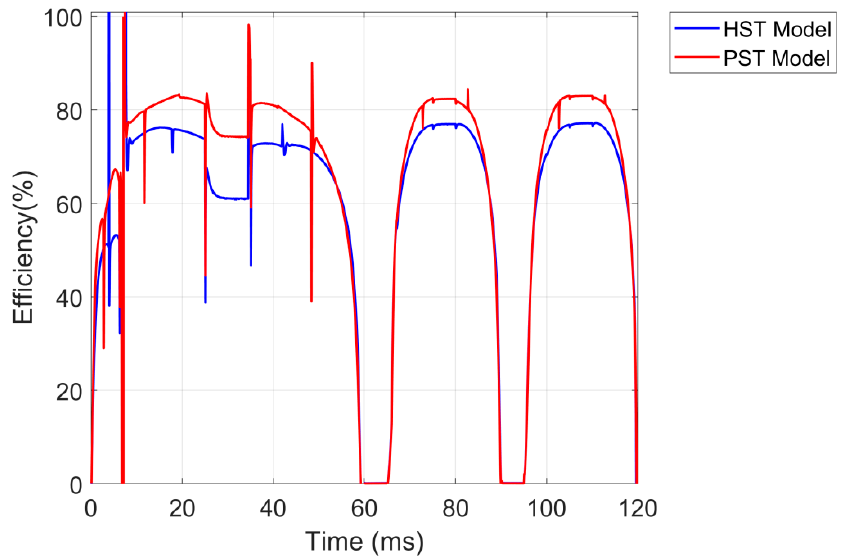
Figure 14. Powertrain Efficiency.